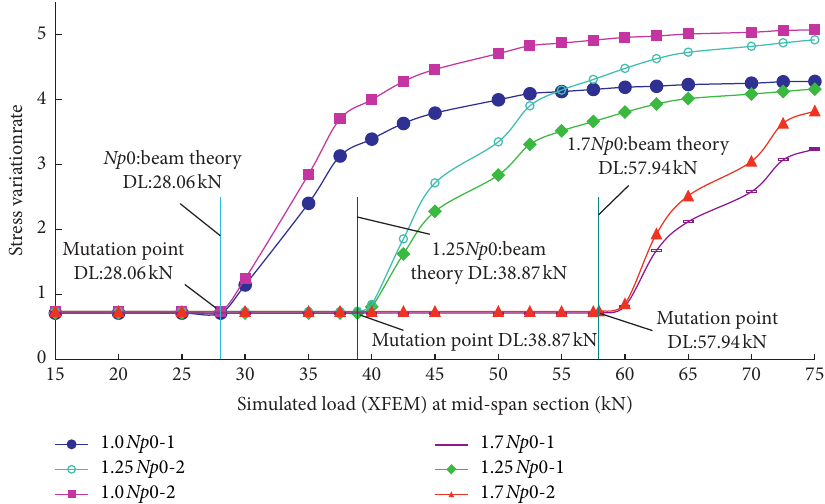
Figure 10: Stress variation rate vs. load curves by the proposed method (rebar